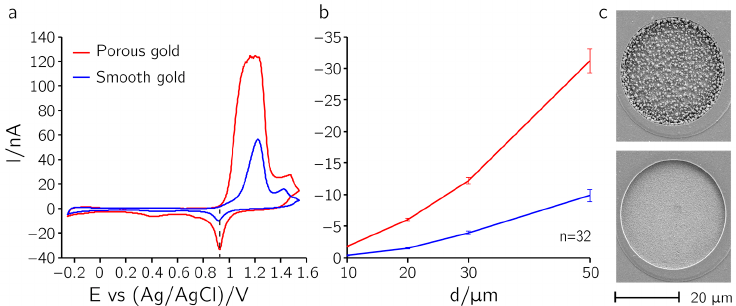
Figure 5. Gold deposition. Cyclic voltammogram (CV) of an electrode with deposited gold layer. ( a ) CV of 50-µm-diameter electrode modified with granular or smooth gold in 0.5 M H 2 SO 4 in a voltage range between − 0.25 V and 1.55 V vs. Ag/AgCl; the sweeping rate was 100 mV/s. A single sharp reduction current peak can be seen at ~0.9 V. Electrodes were completely covered so that no traces of platinum were visible. ( b ) Reduction current peak heights for different electrode diameters for smooth and granular gold layers; ( c ) scanning electron microscope (SEM) of a 30-µm-diameter electrode after deposition of granular gold (top) and smooth gold (bottom) layers.